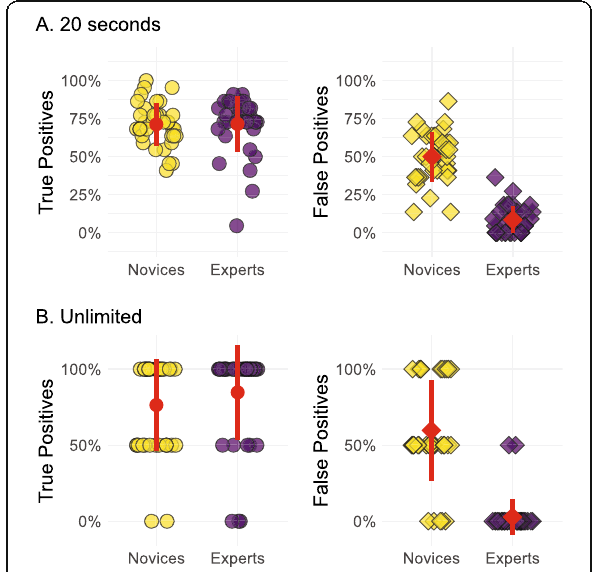
Fig. 1 True- and false-positive rate for individual novices and experts after 20 s of analysis ( a ) or without a time limit ( b ). Each jittered data point represents the mean proportion of true or false positives for each individual participant. The red shape represents the mean and vertical bars ±1 standard